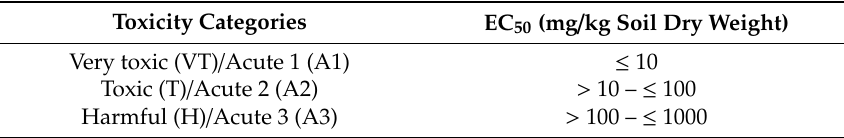
Table 8. Toxicity categories for terrestrial